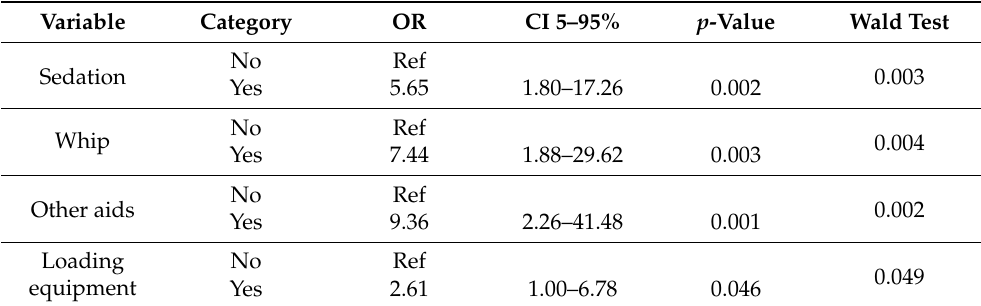
Table 7. Results of the univariable logistic regression with the variables associated with transport- related problem behaviors (TRPBs) reported in the replies ( n = 148) to a survey on horse road transport in Italy. Results are expressed as the odds ratio (OR), confidence interval (95% CI), p -value for each predictive variable and total p value of the Wald test.